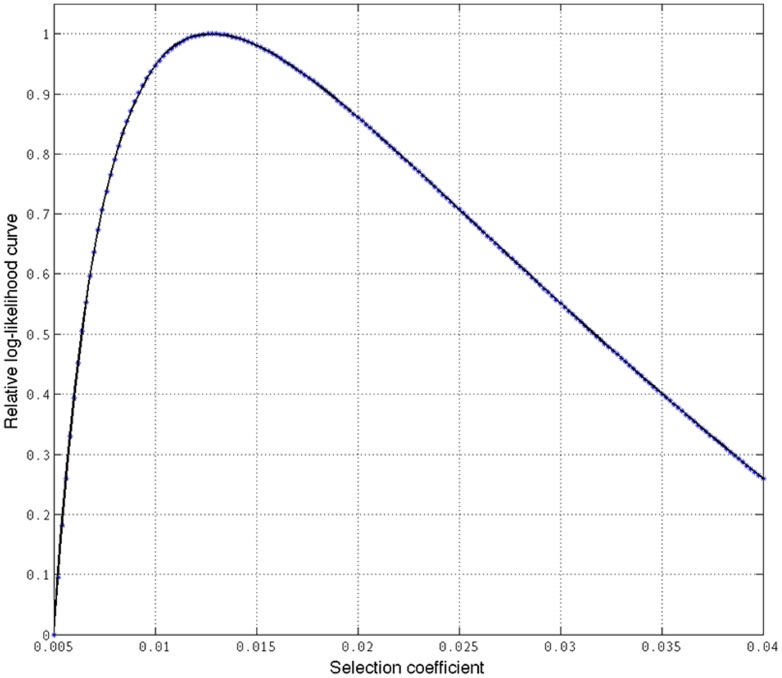
Estimation of selection coefficient (s) of allele 314F using the haplotipic data of 82 unrelated CEU individuals from the 1KGP.The highest likelihood was obtained for s = 0.0127 (95% CI, 0.0106–0.0148).